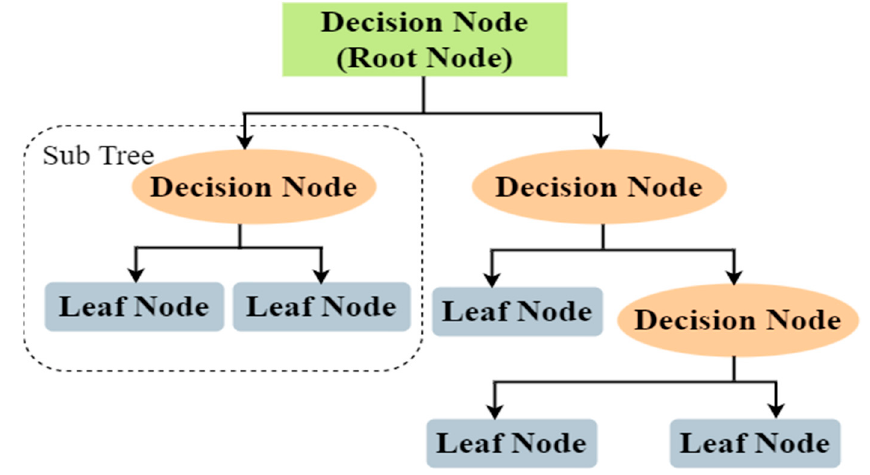
Figure 4. Basic structure of DT.